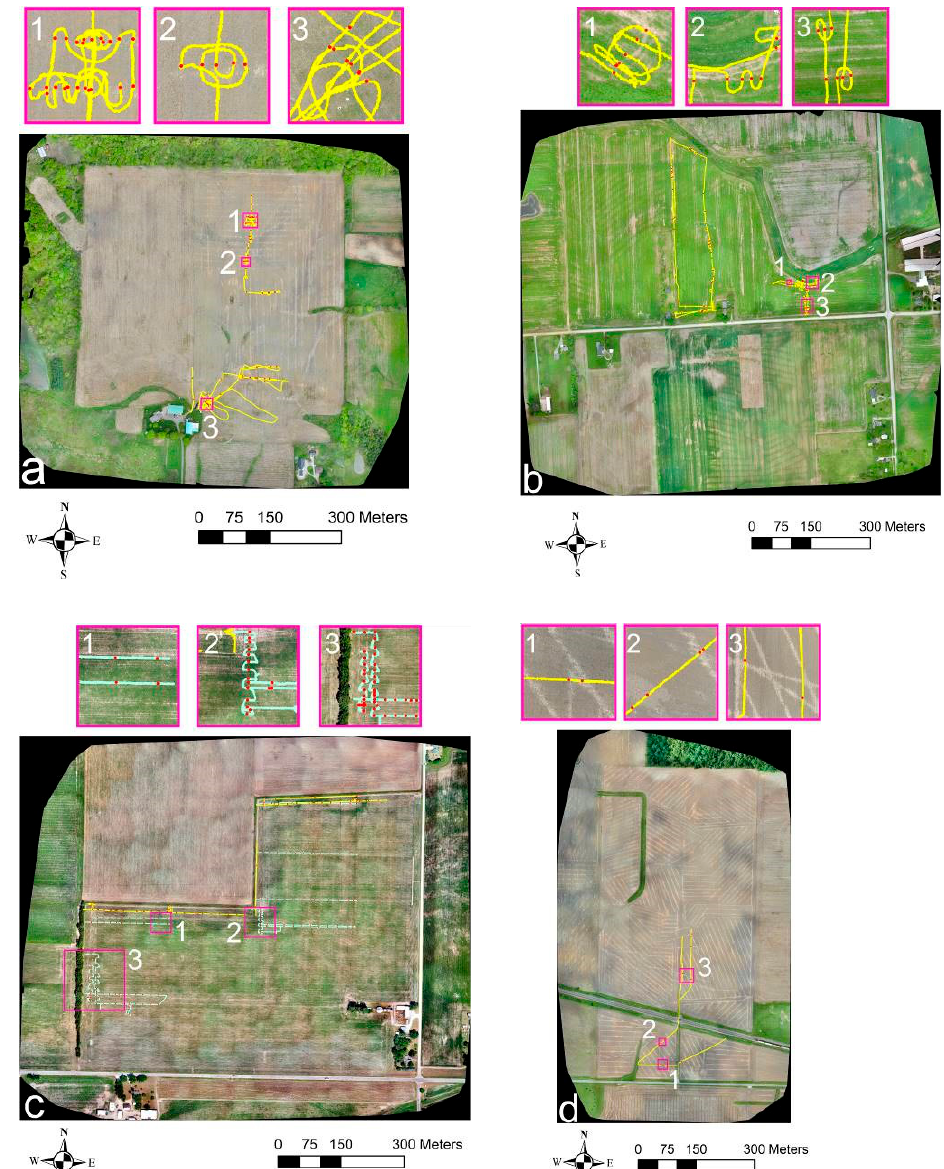
Figure 15. Potential drainage pipe locations marked (with red dots) on the GPR survey transects (yellow and cyan) overlaid on UAV VIS-C orthomosaic imagery: ( a ) Site-1, ( b ) Site-2, ( c ) Site-3, and ( d ) Site-4. The pink boundaries mark the regions of interest.